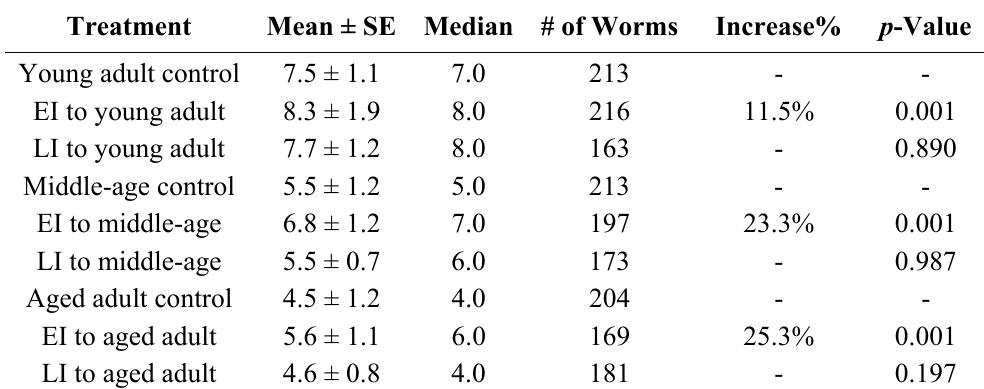
The V. cholera killing assays were repeated at least three times with similar results, and the data for representative experiments are shown. The lifespan data were analyzed using the log-rank test and p -values for each individual experiment are shown. EI represents the early-start intervention. LI represents the late-start intervention. # indicates